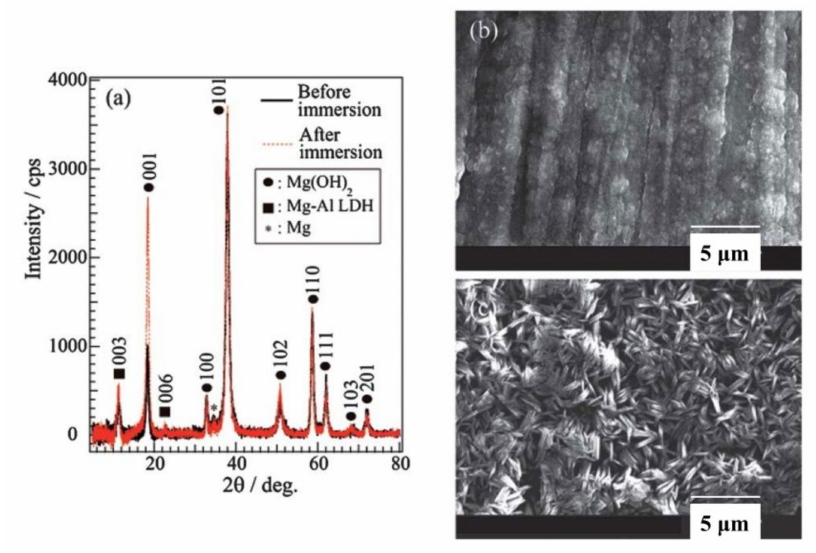
Figure 6. ( a ) XRD patterns of the sample with various treatment, SEM graphics of the film coated AZ31 ( b ) before and ( c ) after immersion. Reprinted with permission from [39]; Copyright 2013 Royal Society of